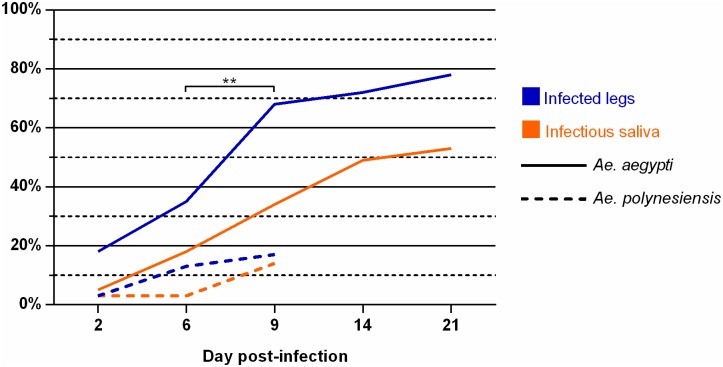
Progression trends of CHIKV dissemination and transmission efficiencies in Ae. aegypti and Ae. polynesiensis.Statistically significant differences between two successive days post-infection are shown by asterisks (** = p<0.01). CHIKV dissemination efficiency showed a dramatic increase in Ae. aegypti from 6 to 9 dpi.